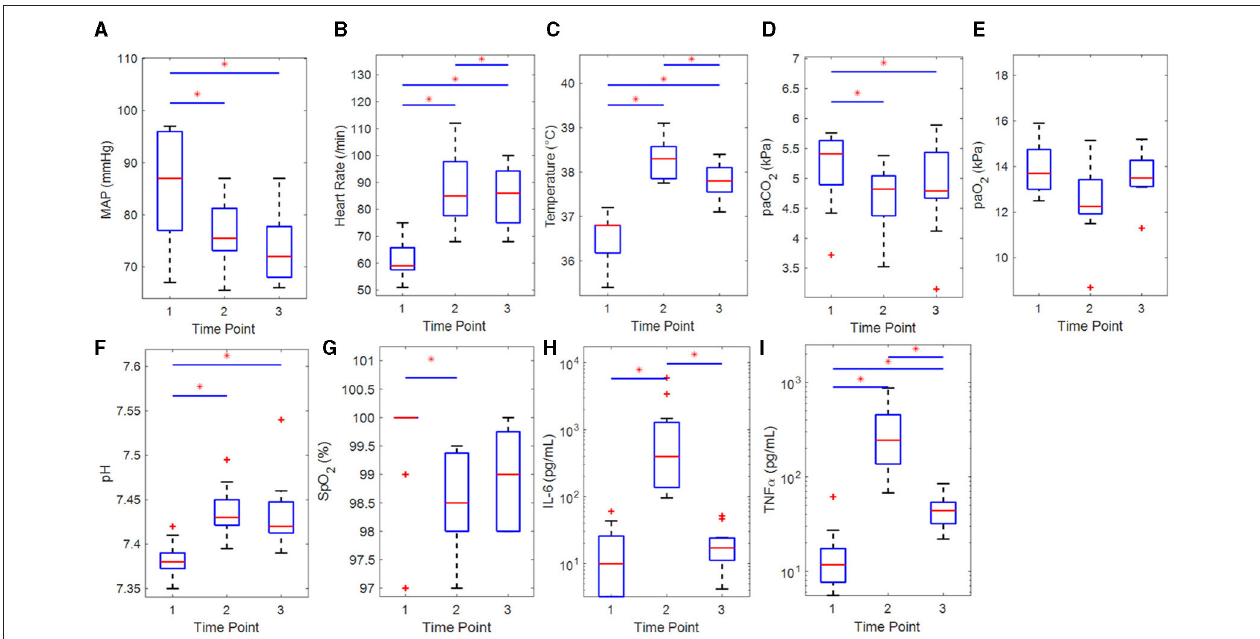
FIGURE 2 | Boxplots of hemodynamic and clinical parameters of the participants ( n = 11) for each time point with results of the statistical comparisons. (A) Mean arterial pressure (rm-ANOVA), (B) heart rate (rm-ANOVA), (C) temperature (Sign. Rnk), (D) PaCO2 (Sign. Rnk), (E) PaO2 (Sign. Rnk), (F) pH (Sign. Rnk), (G) SpO2 (Sign. Rnk), (H) IL-6 (Sign. Rnk), and (I) TNF α (Sign. Rnk). IL, interleukin; MAP, mean arterial pressure; PaO 2 /PaCO 2 , arterial partial pressure of oxygen/carbon dioxide; rm-ANOVA, repeated-measures analysis of variance; Sign. Rnk, Wilcoxon’s signed rank test; SpO 2 , arterial saturation of oxygen; TNF α , tumor necrosis factor alpha. * p < 0.05 for difference between time points.